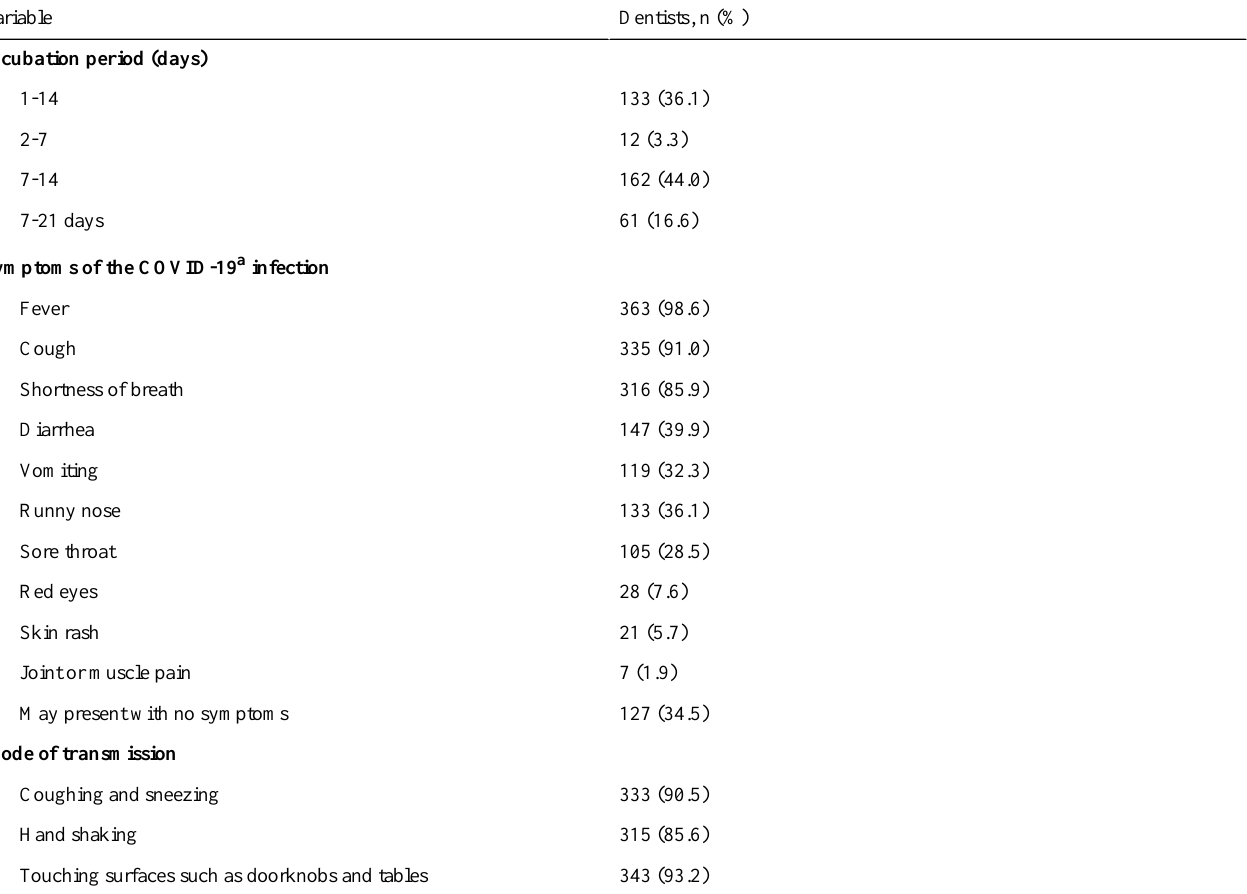
Table 2. Dentists’awareness about incubation period, symptoms, and mode of transmission of the coronavirus disease infection (N=368).